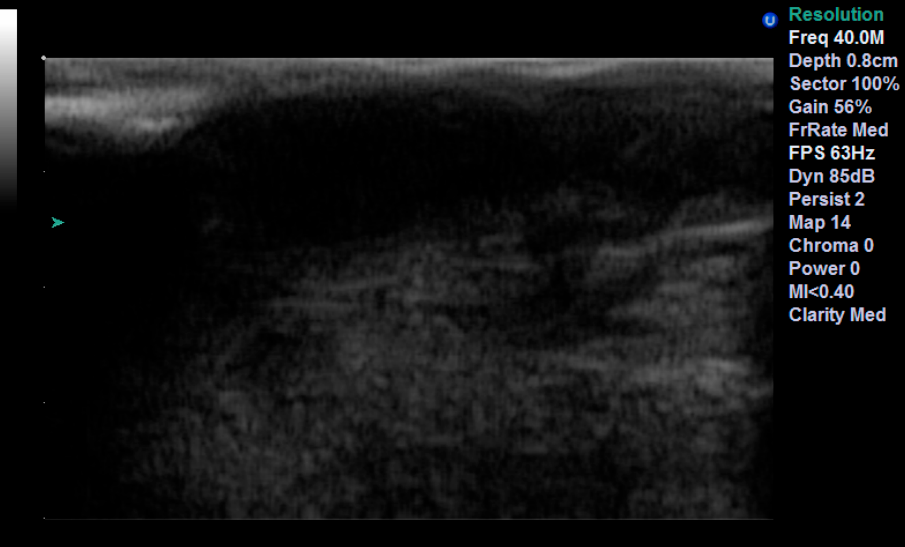
Figure 5. Misdiagnosed BCC due to the absence of hyperechoic spots . Table 3. Concordance between histopathological diagnosis, echographic diagnosis and hyperechoic spots.